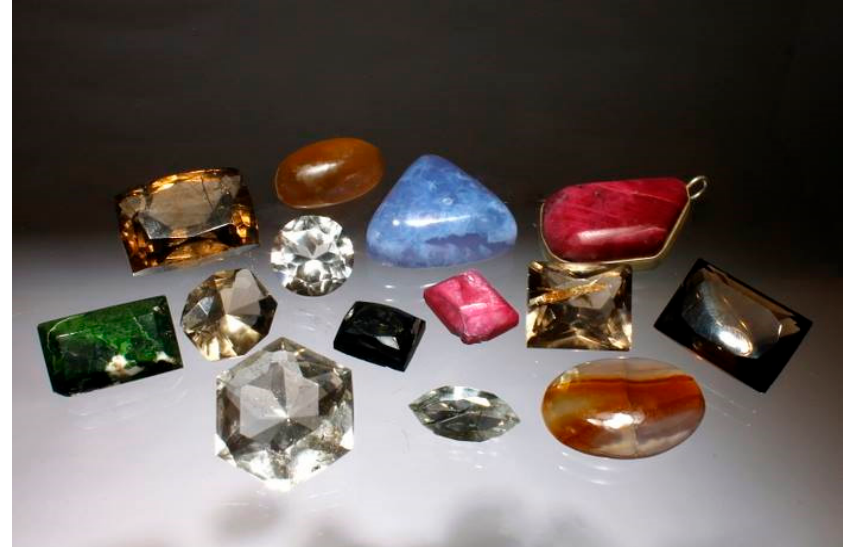
Figure 15. Various faceted and cabochon gemstones from Greece. Green Mn-andalusite from Thassos (2.2 cm length) in the left, dark green epidote from Kimmeria (1.3 cm) in the center, ruby from Paranesti (4 cm) in the right of the photograph. The rest are silica varieties. Photo courtesy of Anastasios Tsinidis.